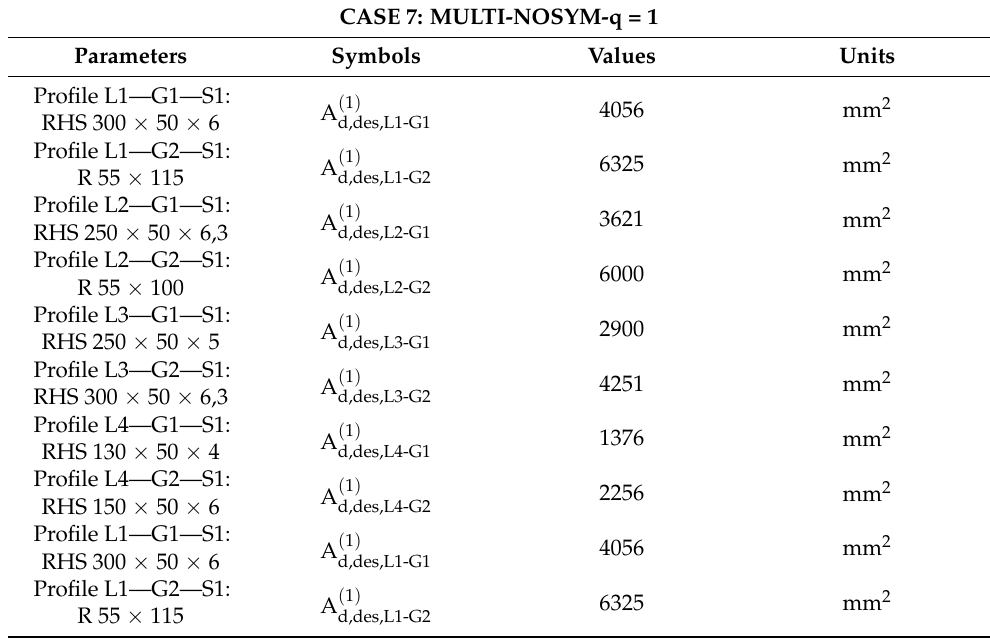
Table 20. Results of case study 8 (L: level; G: group; S: step).